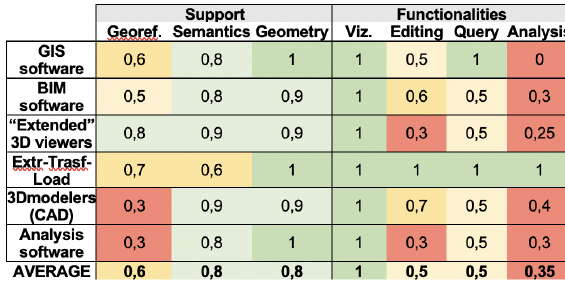
Figure 2. Synthesis table of the delivered tests regarding support for IFC (benchmark Task 1). The color scale green to red is assigned according to the scores from 1-full support to 0-no